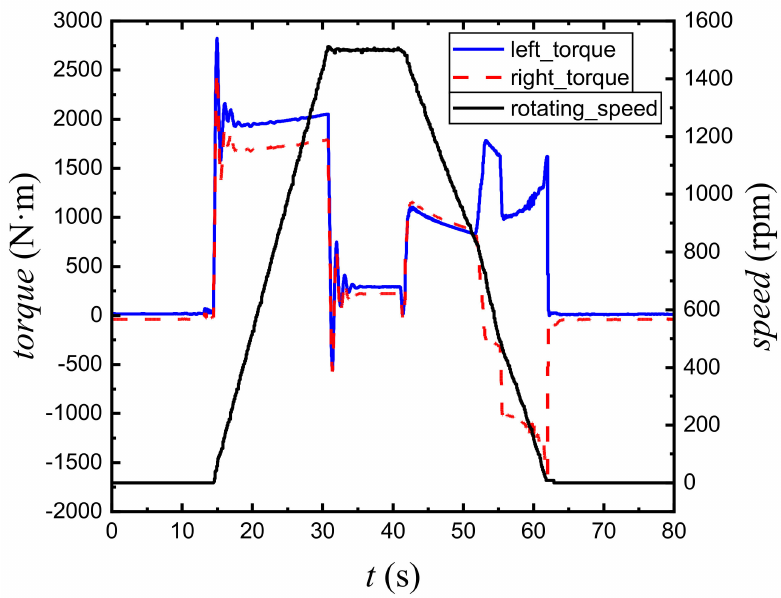
Figure 25. Tracked vehicle left / right torque and drive wheel rotation speed.